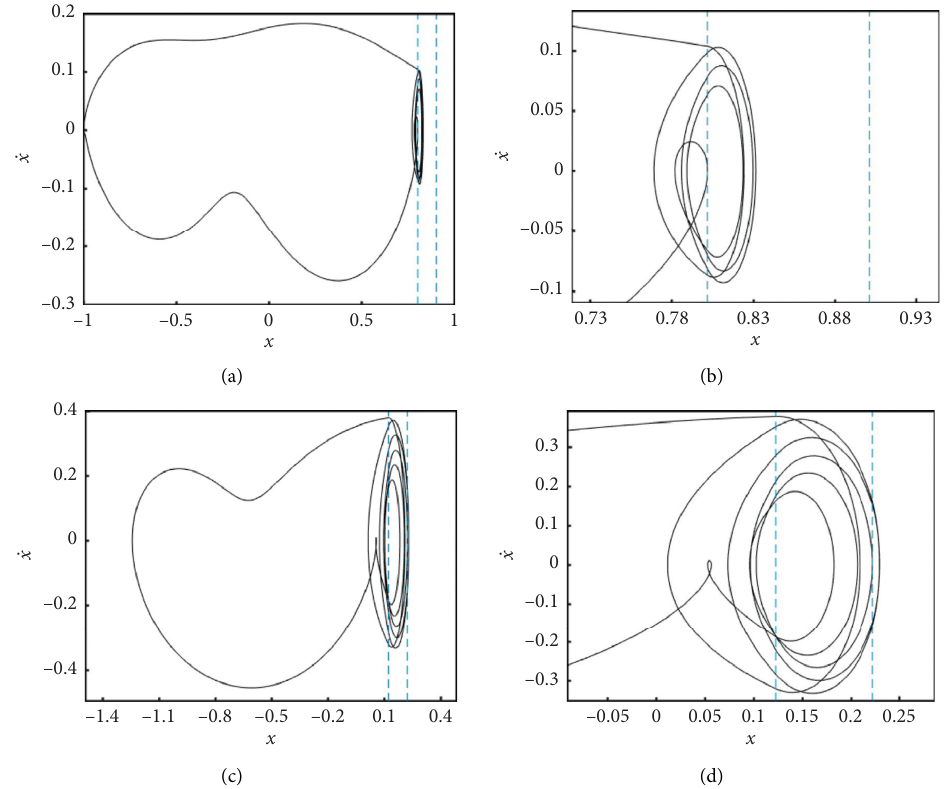
Figure 5: Phase diagram of periodic motion. (a) 1 − 4 − 0 phase diagram of grazing periodic motion. (b) Partially enlarged view of Figure 5(a). (c) 1 − 6 − 2 phase diagram of grazing periodic motion. (d) Partially enlarged view of Figure 5(d).